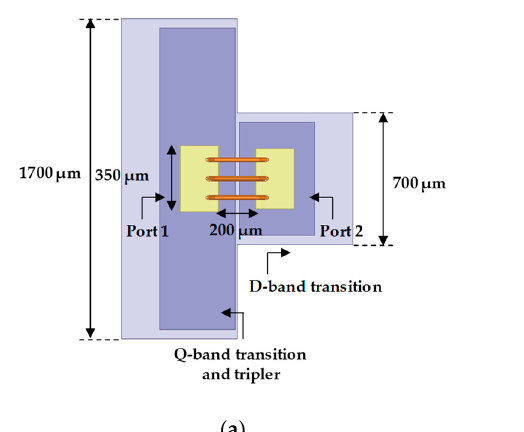
Figure 9. Simulation of bond ‐ wire effect. ( a ) Top view and ( b ) cross ‐ sectional view.